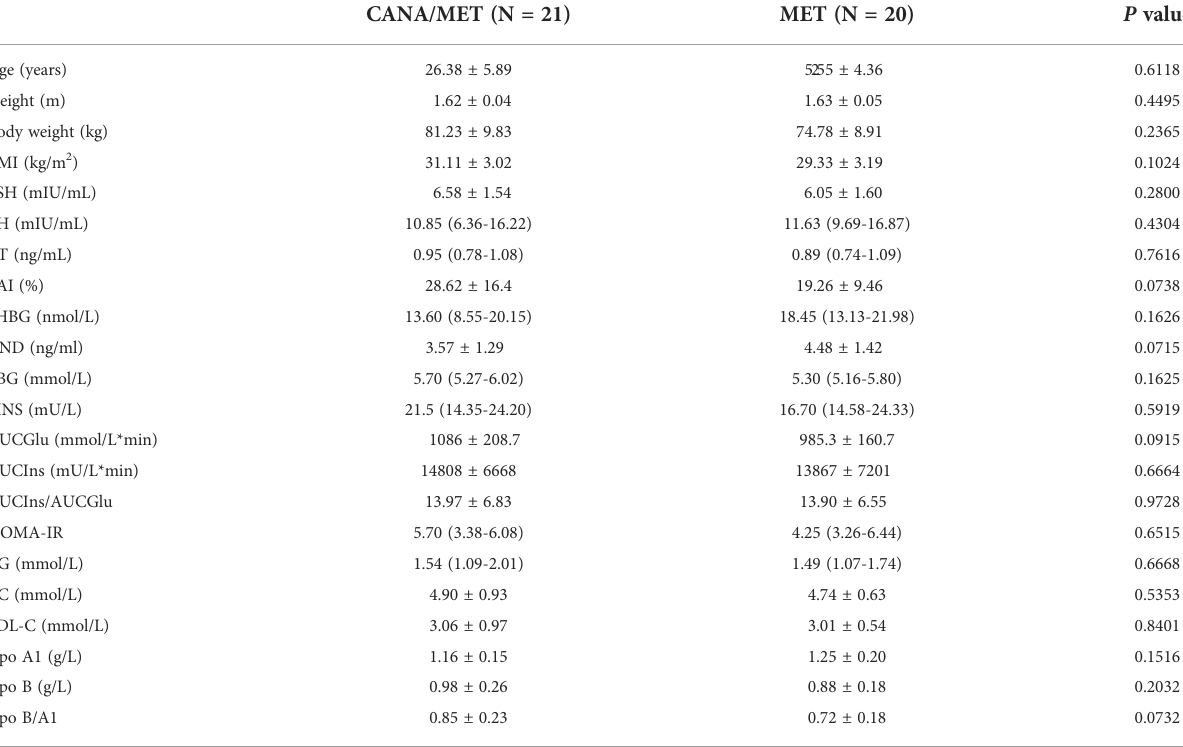
TABLE 1 Demographic data and baseline characteristics of